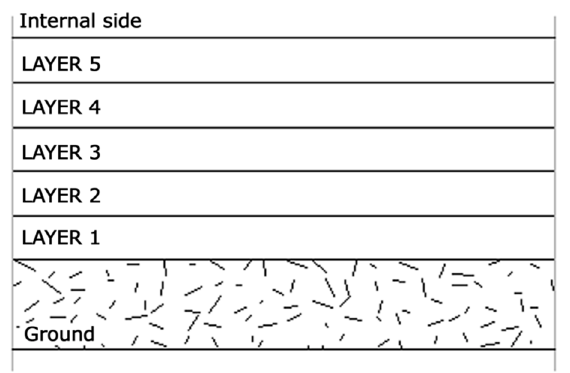
Figure 2. Stratification of the slab-on-ground floor with no imposed constraints.